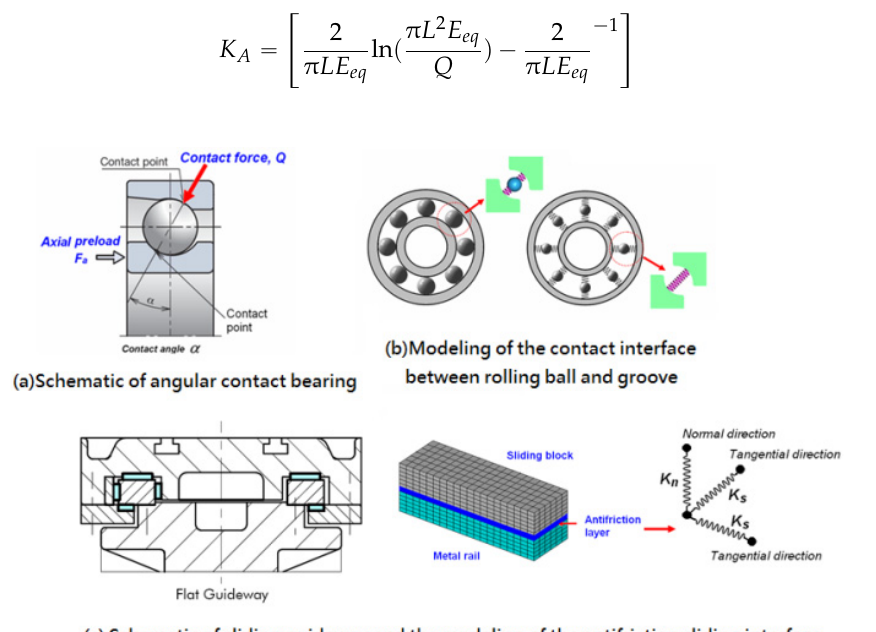
Figure 2. Modeling of the rolling and sliding interfaces. ( a ) Schematic of angular contact bearing, ( b ) Modeling of the contact interface between rolling ball and groove, ( c ) Schematic of sliding guideway and the modeling of the antifriction sliding interface.